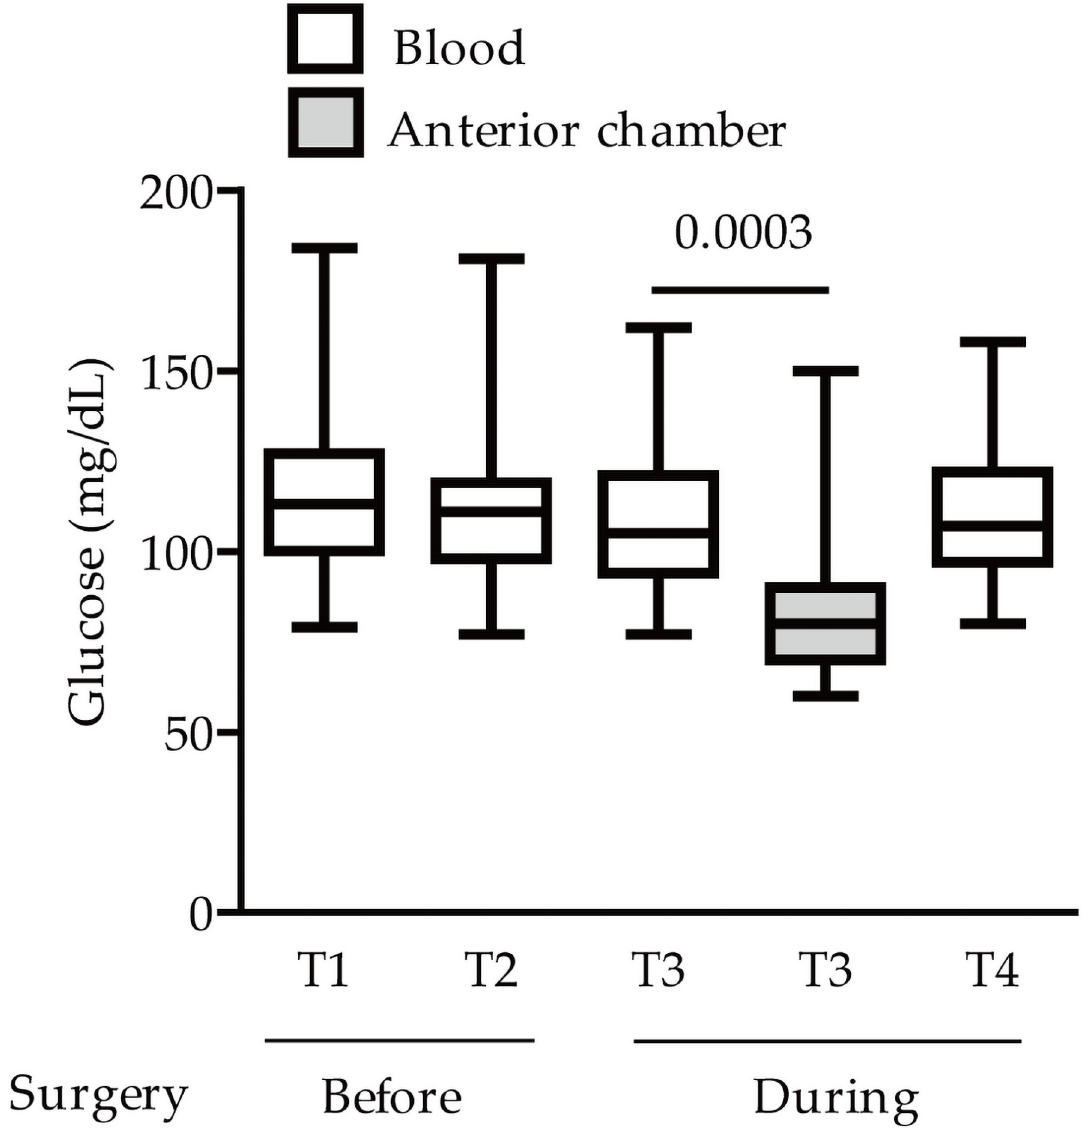
Fig 3. Glucose levels from the anterior chamber and blood in Study 2 subjects with cataracts. Quantitative analyses showed that there was no significant difference in glucose levels between the ‘before/during the surgery’, detected by the UV-hexokinase method (n = 19 from 20; unfortunately, 1 sample had a measurement error during the surgery, hence, it was excluded). The levels from the anterior chamber were significantly lower than those from the blood, p = 0.0003. T1: the time that the patients entered the operation room (before the surgery), T2: after T1 with a 5 mins interval (before the surgery), T3: the timing of surgery, and T4: after T3 with a 5 mins interval (during the surgery). Graphs are presented as median with interquartile range, the 25th and 75th percentile. The data were analyzed using Student’s t -test and one-way ANOVA followed by a Bonferroni post hoc test.